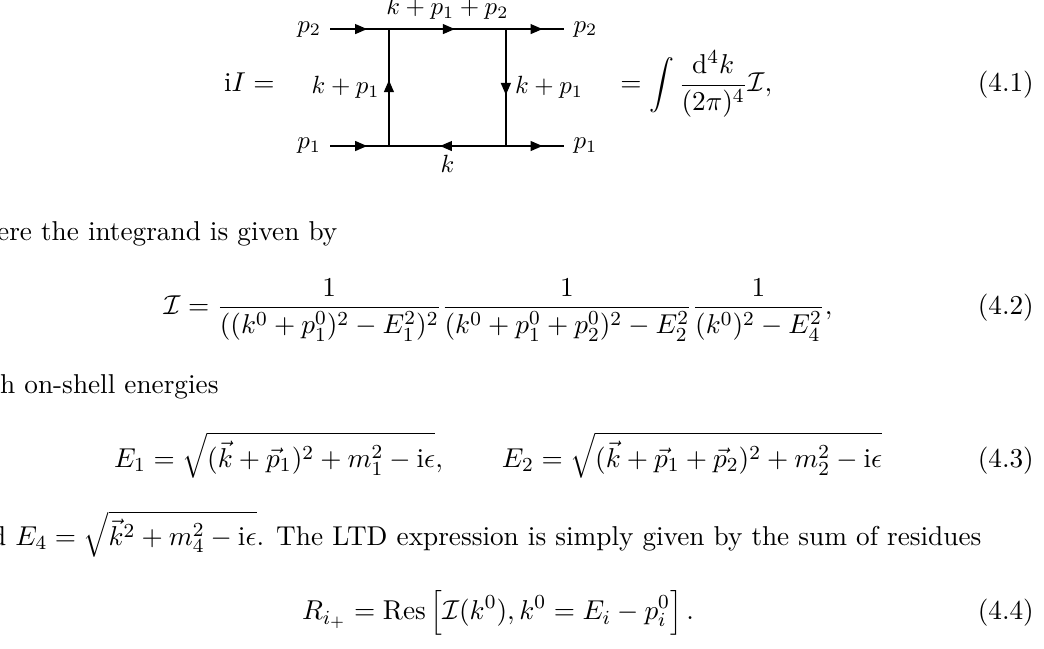
Table 5. The scalar box topology Box_4E , whose kinematic configuration does not allow for a source in the interior of all E-surfaces (see figure 9). However, an exterior source can be found that enables local cancellations of all poles of E-surface residues. The subtracted integrand (real part) and the sum of residues (imaginary part) have integrable singularities at the tangents of the E-surfaces through the